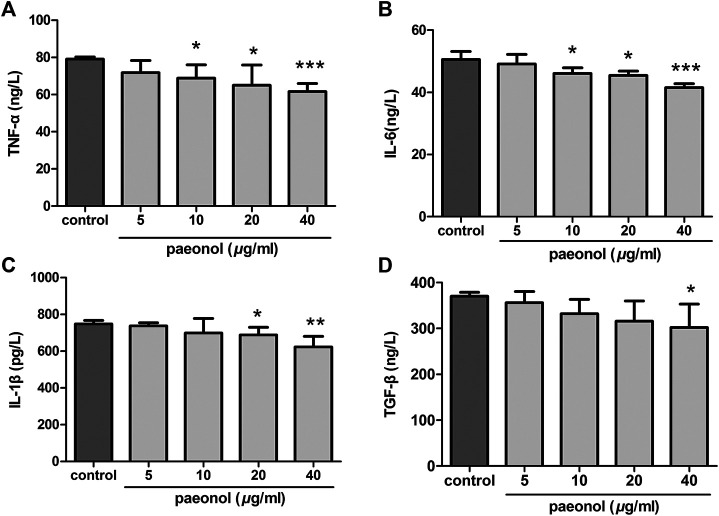
Paeonol reduces secretion of inflammatory cytokines in A549 cells. A549 cells were treated with paeonol at indicated concentrations for 24 h. ELISA was used to determine the levels of TNF-α (A), IL-6 (B), IL-1β (C), and TGF-β (D) in supernatants, n = 3 (independent experiments). Significance: *p < 0.05 vs. control, **p < 0.01 vs. control, ***p < 0.001 vs. control.